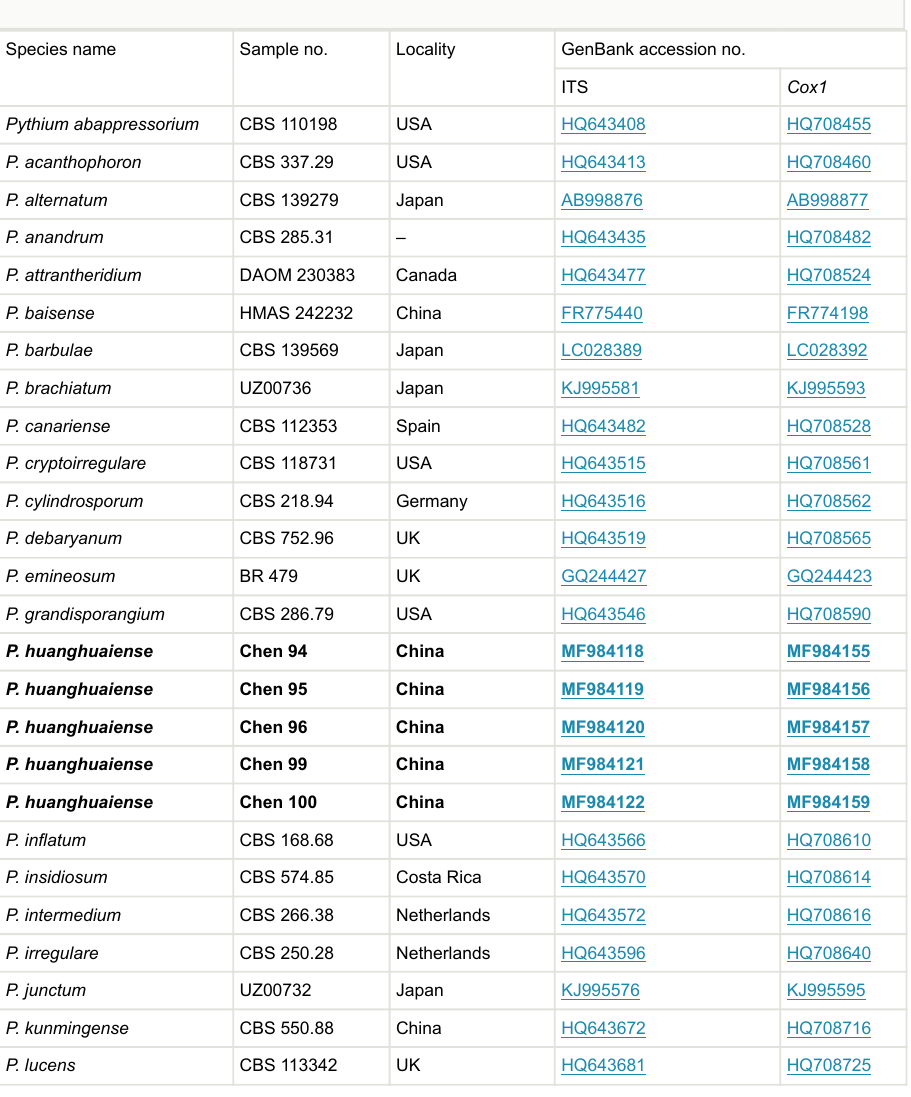
A list of species, cultures and GenBank accession numbers of sequences used in this